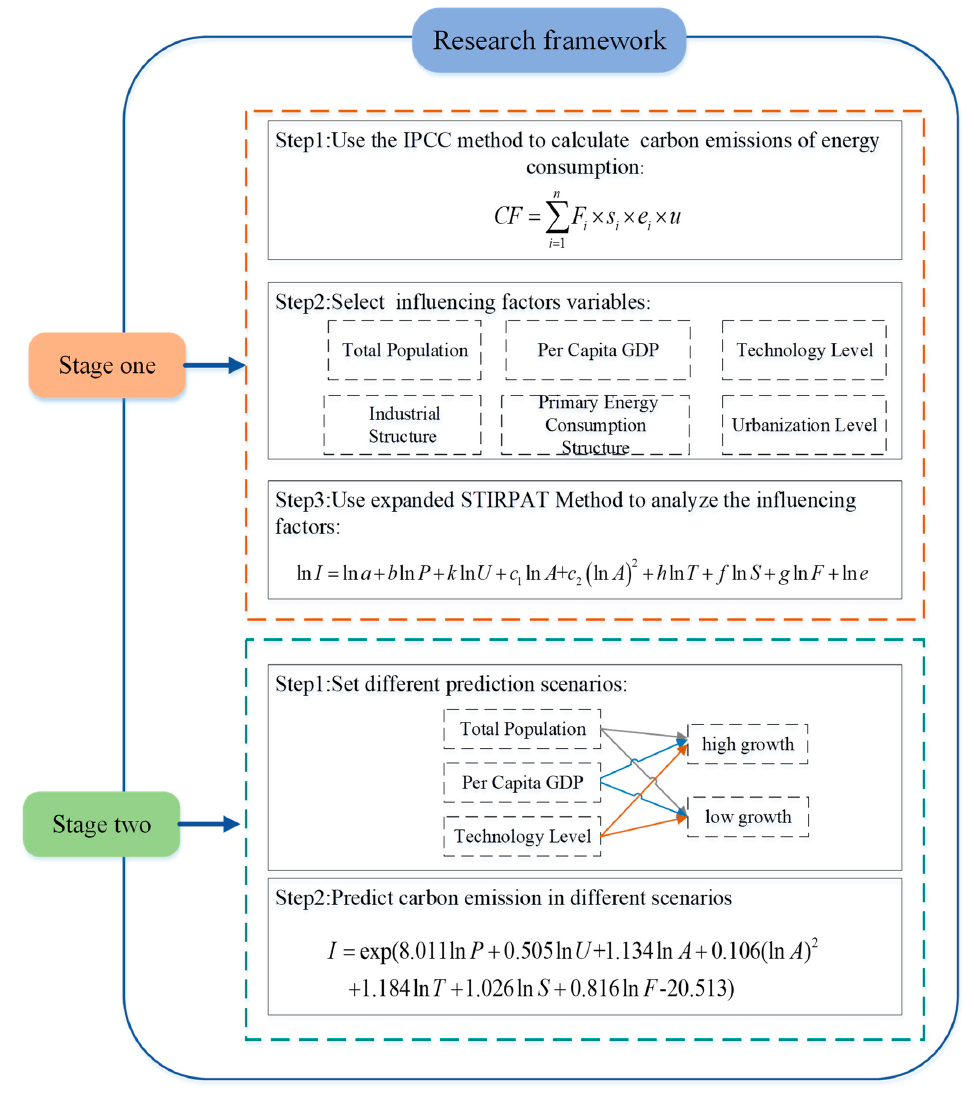
Figure 1. The research structure of the article.2. Establishment of Influencing Factors Regression Model.